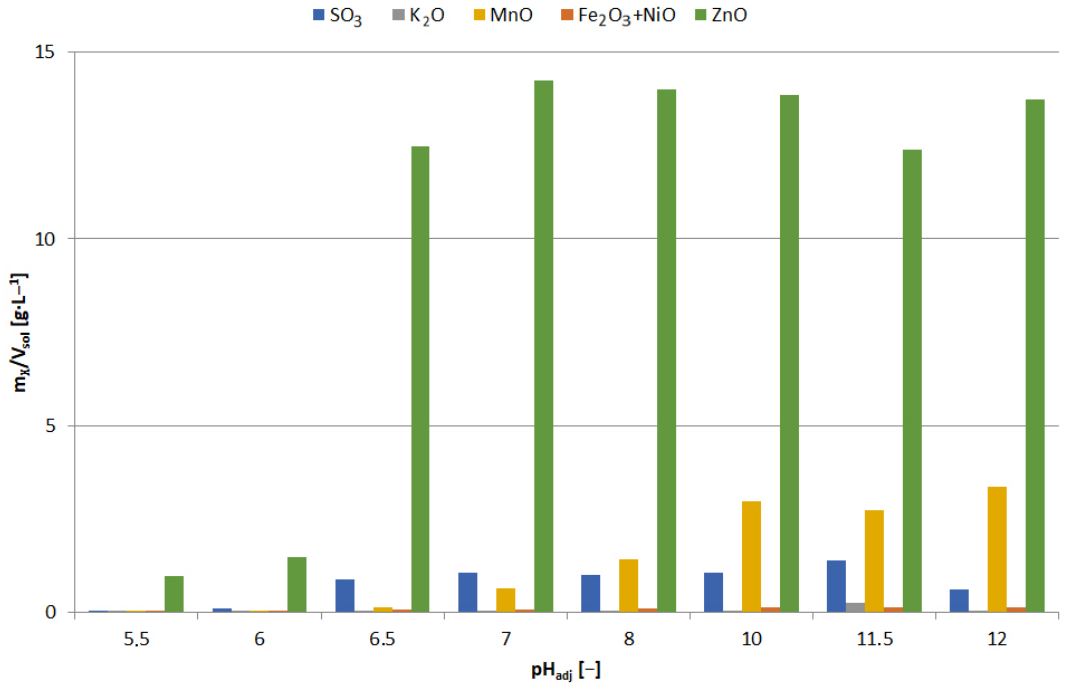
Figure 14. Effect of adjusted pH (pH adj ) on amount of precipitated compound (m X /V sol ) as a result of precipitation by using NaOH from selective leaching solution .